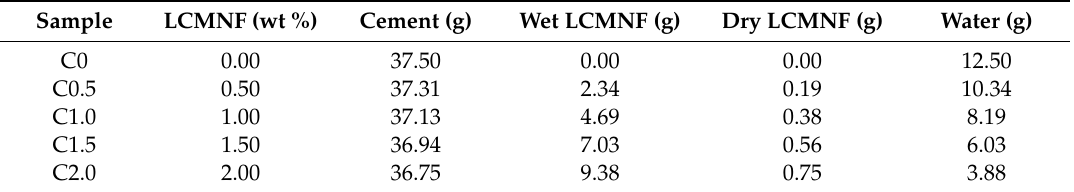
Table 3. Experimental batch and doses of each material for a batch of 50